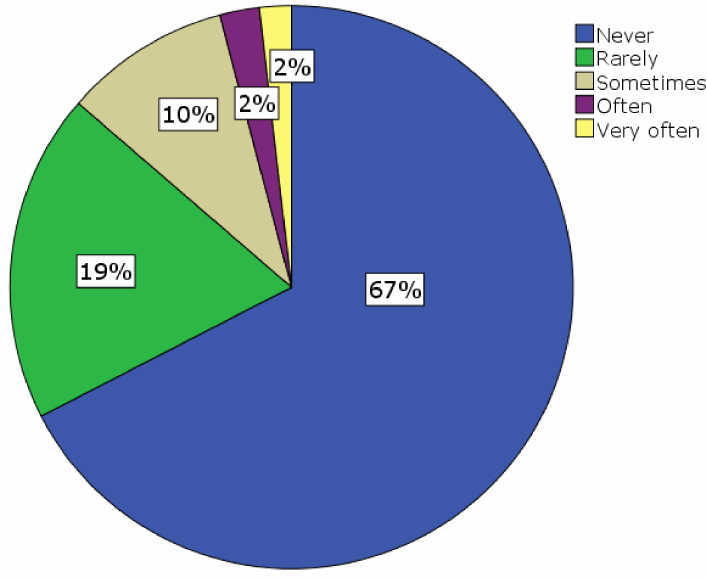
Figure 3. How often does a disability or poor health prevent you from walking in